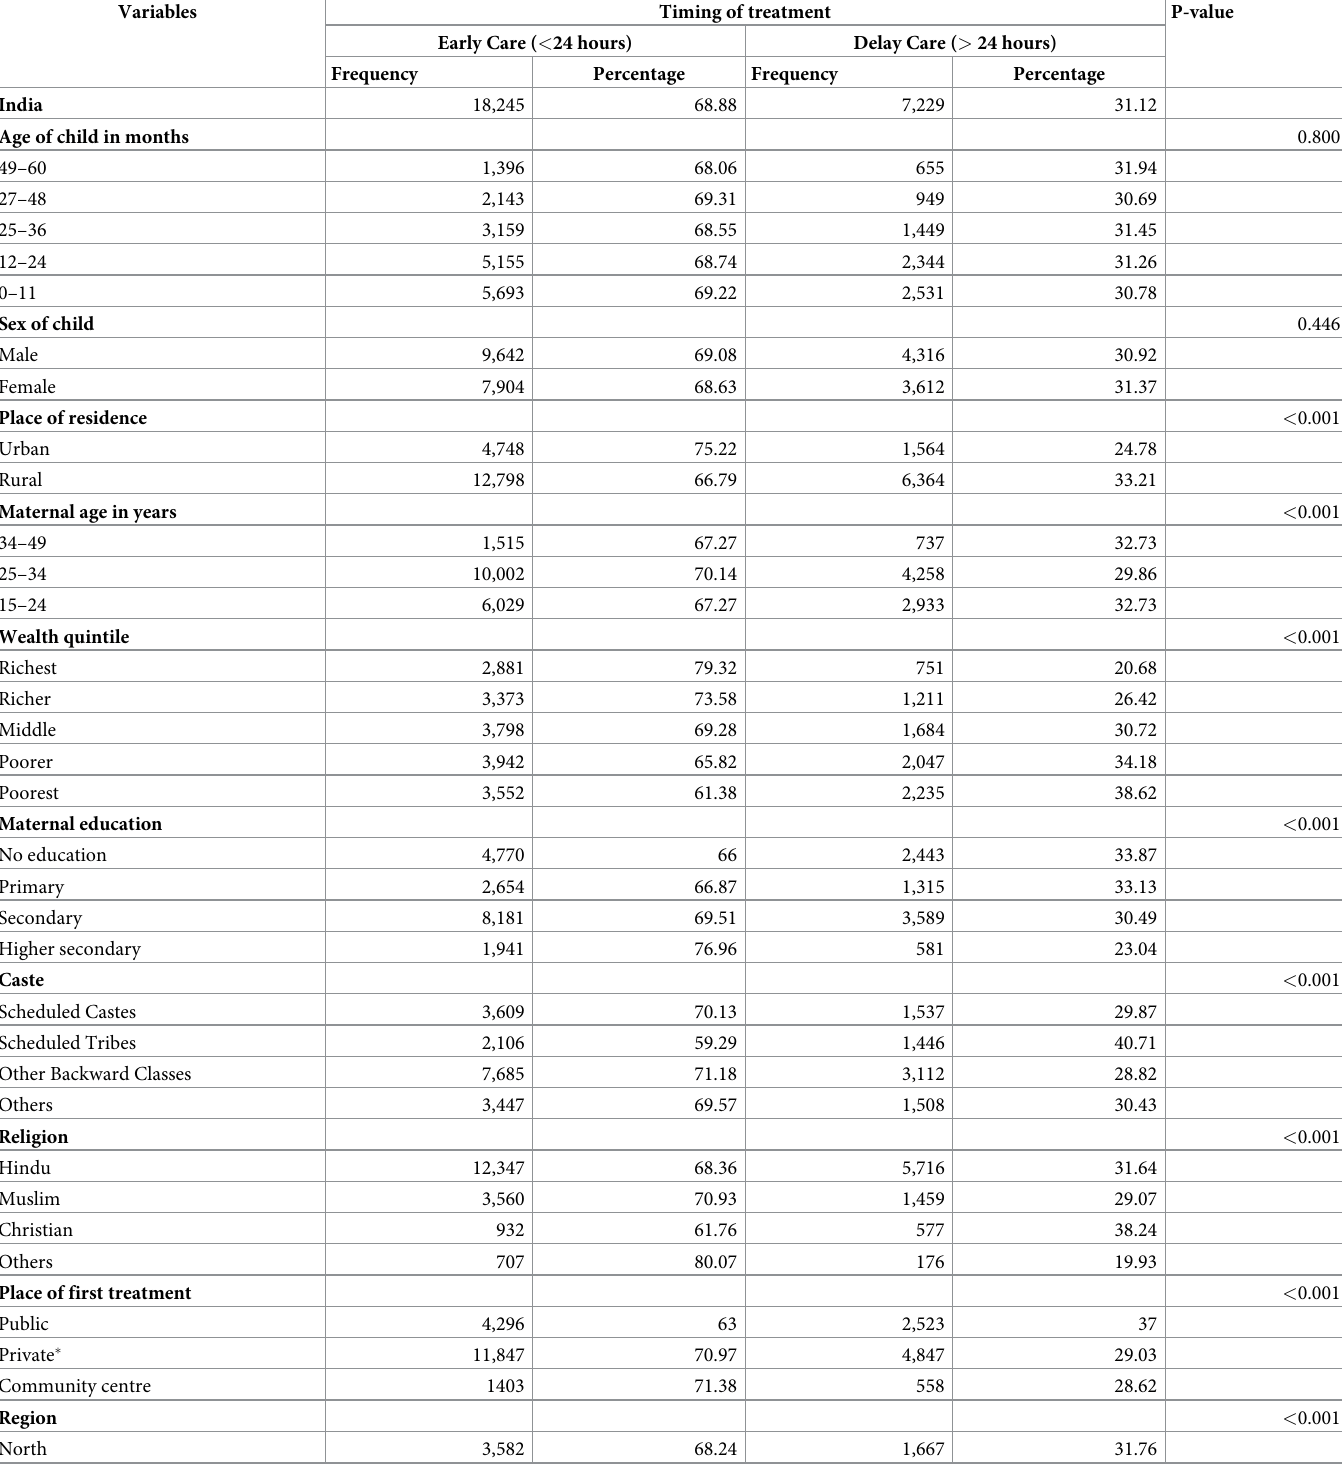
Table 1. Demographic, socio-economic and regional differential in treatment-seeking behaviour of caregivers of under-five children with fever in India, NFHS-4